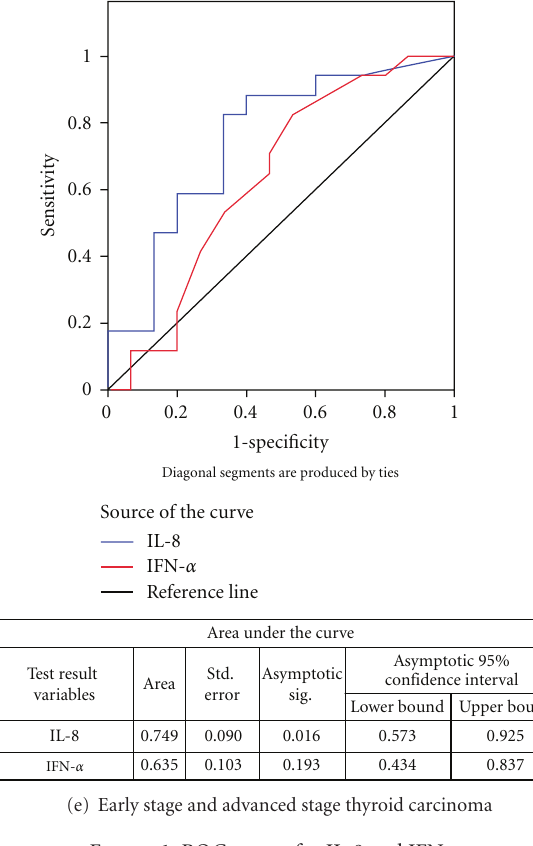
Figure 1: ROC curves for IL-8 and IFN- α